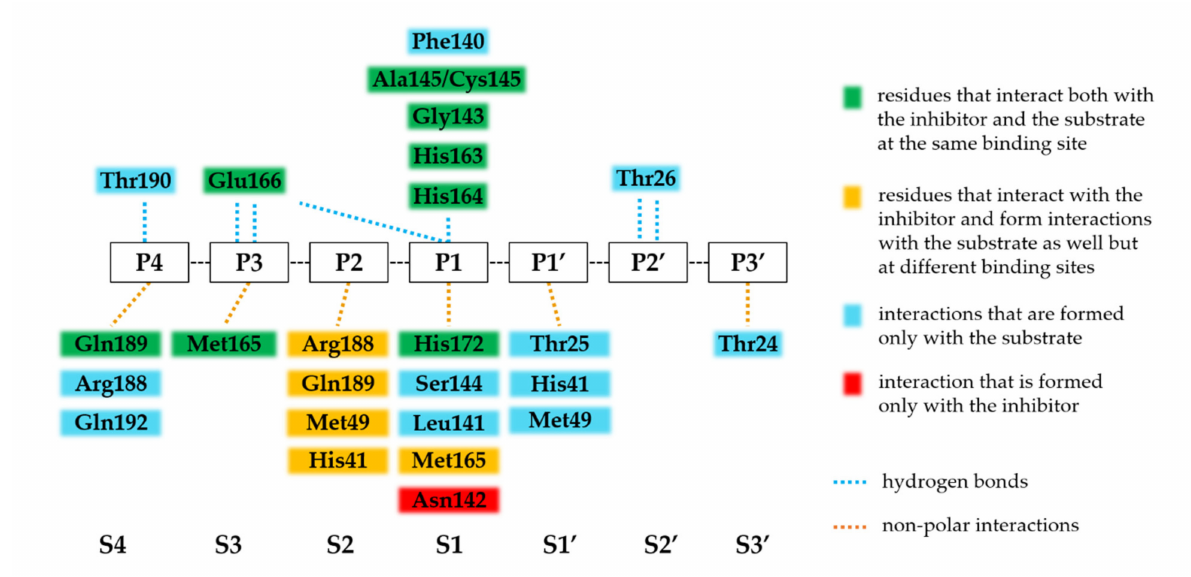
Figure 2. Comparison of substrate- and nirmatrelvir-binding interactions of SARS-CoV-2 Mpro. The interactions are represented based on Table 1. An interaction was considered as relevant if it was present in >50% of the studied enzyme-substrate or enzyme-nirmatrelvir complexes. The enzyme-substrate complexes contain modified catalytic residue (C145A). The substrate binding sites at the active site (S4-S3’) and the substrate residues (P4-P3’) that bind to these sites are labeled based on nomenclature introduced by Schechter and Berger [85], and the scissible bond is located between P1 and P1’